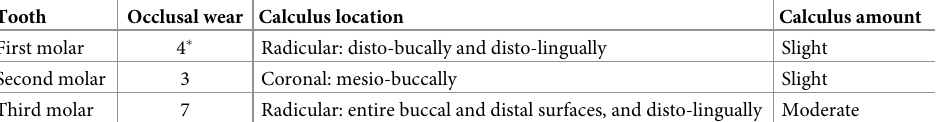
Table 3. Right maxillary molar wear (Smith’s system, in [46]) and calculus development (after [43]) evident in Maros-LBB-1a. Tooth Occlusal wear Calculus location Calculus amount First molar Radicular: disto-bucally and disto-lingually Slight Second molar 3 Coronal: mesio-buccally Slight Third molar 7 Radicular: entire buccal and distal surfaces, and disto-lingually Moderate � The mesio-lingual corner of the tooth was chipped off during life, making assessment of the tooth’s occlusal wear